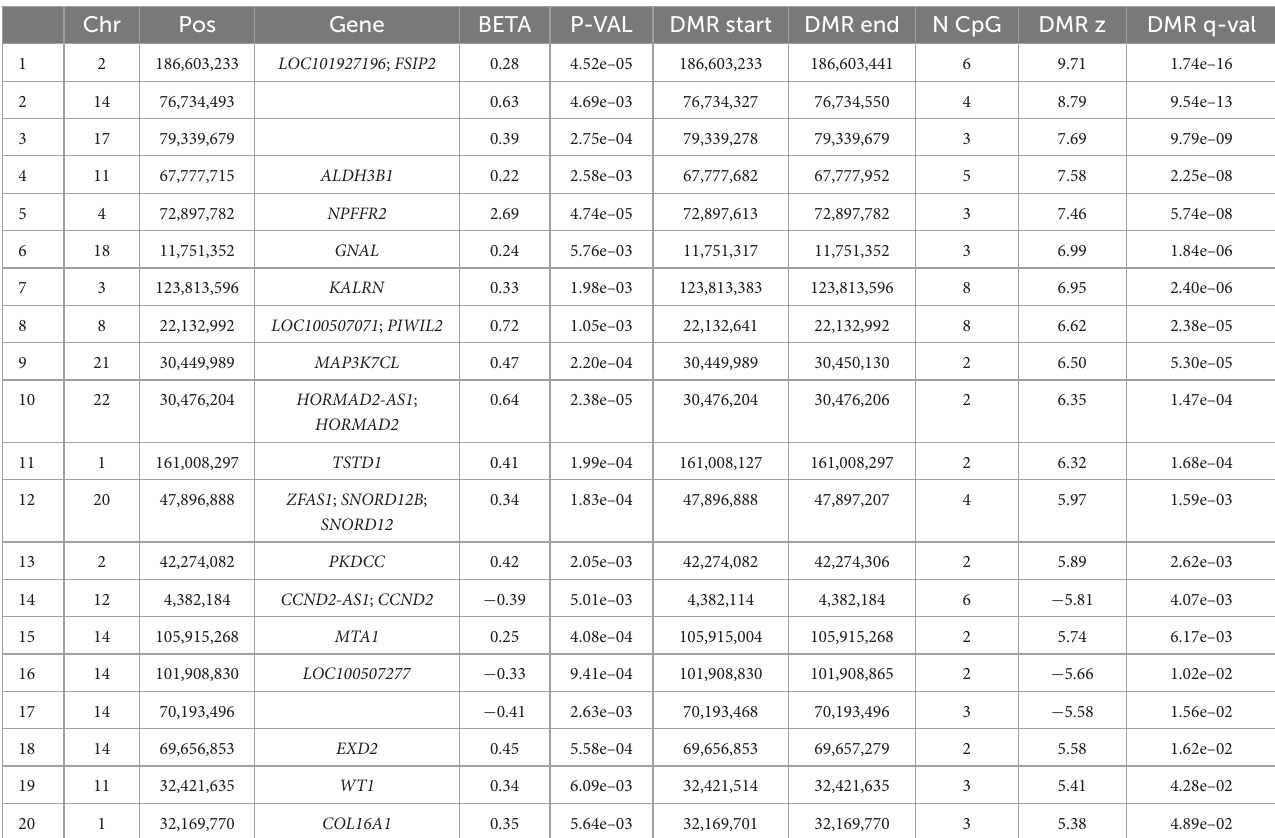
TABLE 2 Cocaine use disorder (CUD)-associated differentially methylated regions (DMRs) ( N =